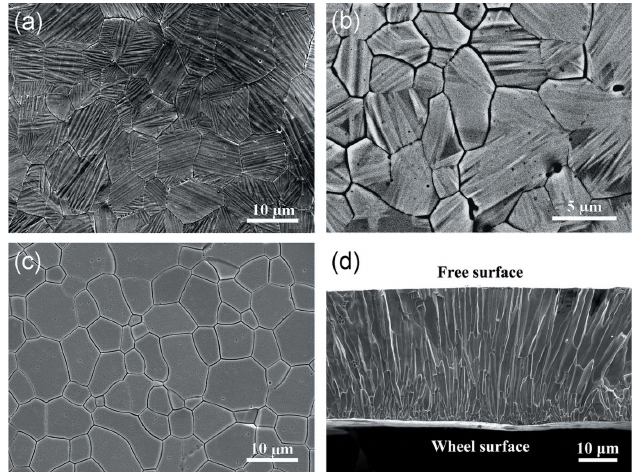
Figure 3 ( a ), ( b ) Backscattered electron (BSE) images of the ribbon plane surfaces for Mn 50 Ni 41 Co 1 Sn 8 and Mn 50 Ni 37 Co 5 Sn 8 ribbons, respectively. ( c ), ( d ) Secondary electron (SE) images of the ribbon plane surface for Mn 50 Ni 34 Co 8 Sn 8 ribbons and of the cross-section for Mn 50 Ni 36 Co 6 Sn 8 ribbons, respectively.